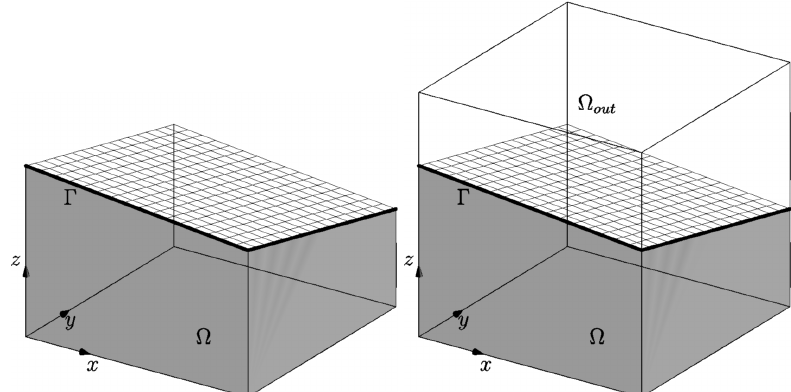
Figure A1. On the left we show the physical domain. On the right the physical domain (gray) is embedded in a larger computational domain ( Ω